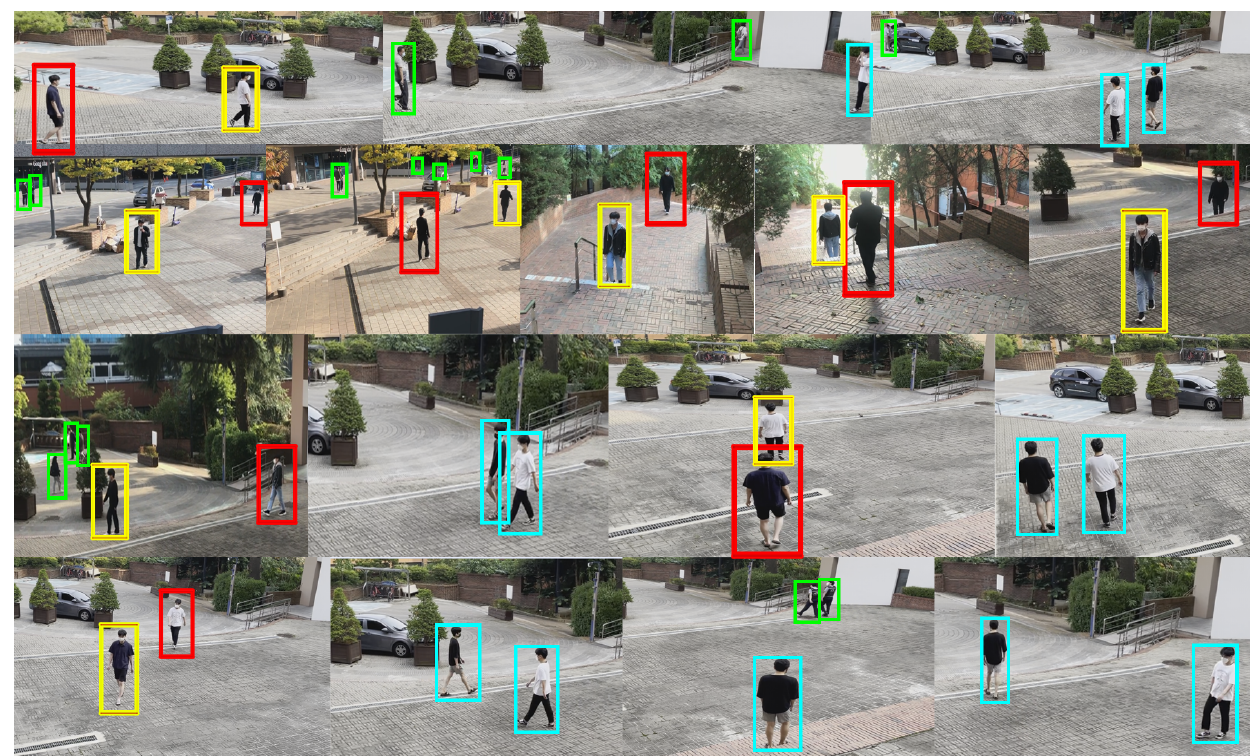
Figure 5. Frames of different videos from the Sogang Tailing Dataset (STD). Suspect: Red rectangle, Victim: Yellow rectangle, Pedestrians: Green rectangle, Volunteers mimicking a non-tailing event: Cyan rectangle.